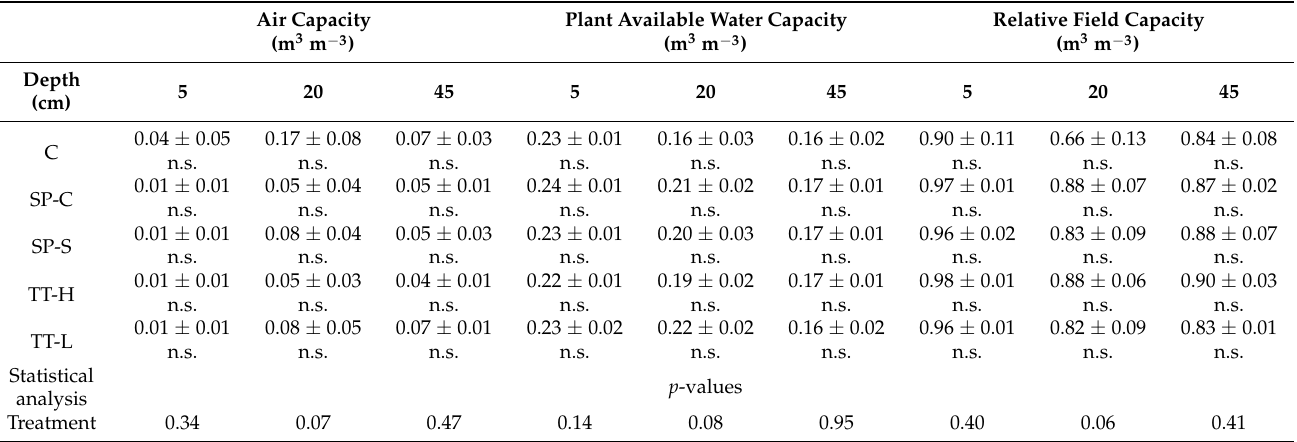
Table 8. Average air capacity (m 3 m − 3 ), plant available water capacity (m 3 m − 3 ) and relative